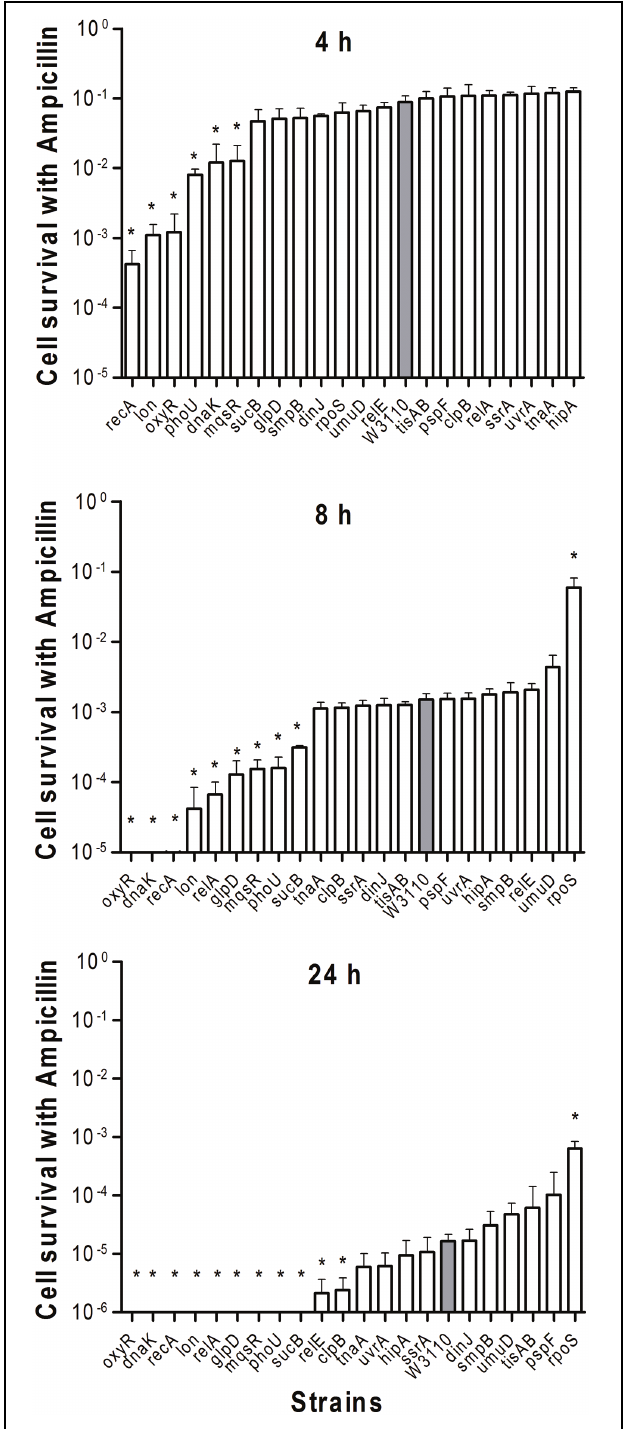
FIGURE 2 | Deletion mutant ranking depends on cell survival over time under conditions of norfloxacin exposure. Stationary phase cultures of W3110 and single-gene mutants were diluted 100-fold and exposed to 4 μ g/ml norfloxacin for 4, 8, and 24 h. The data for each mutant was plotted and compared with that of W3110. Error bars indicate the standard deviation ( n = 3). The asterisk indicates statistical significance as determined using Mann–Whitney U tests ( ∗ P <